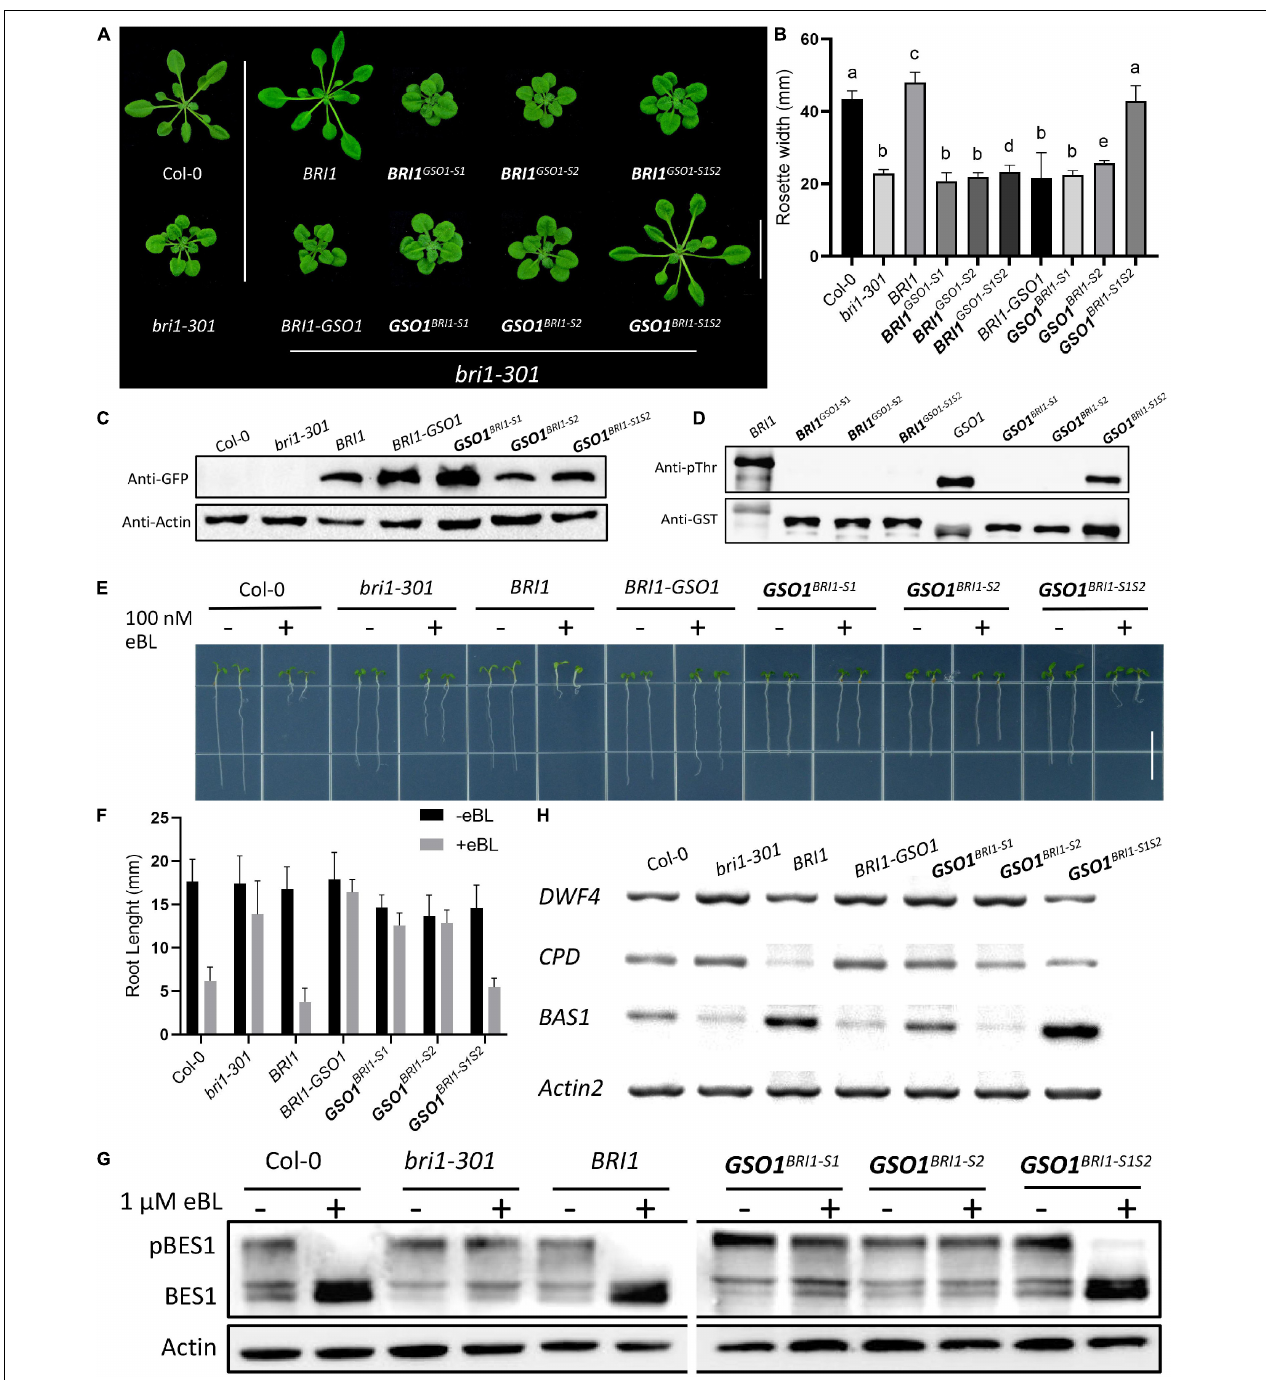
FIGURE 4 | The kinase function of BRI1 defined by two separate domains. (A) The phenotypes of transgenic lines expressing different chimeric receptors of BRI1 and GSO1. Only chimeric receptors with both the S1 and S2 domains of BRI1 ( BRI1 and GSO1 BRI 1 - S1 S 2 ) rescued the mutant phenotypes but not the others ( GSO1 BRI 1 − S 1 , BRI1 GSO 1 − S 1 , BRI1 GSO 1 − S 2 , and GSO1 BRI 1 − S 2 ). Scale bar = 2.0 cm. (B) Measurement of rosette width of transgenic lines ( n = 15), p < 0.0001, one-way ANOVA with a Tukey’s test. (C) The protein expression level of corresponding lines. Actin served as a loading control. (D) Phosphorylation of GST-fused BRI1, GSO1, and their chimeras. The anti-pThr antibody was used to detect the autophosphorylation level. GST-tagged proteins were detected by anti-GST antibody served as a loading control. (E) The root of the 7-day-old seedling grown under light conditions on 1/2MS media supplemented with eBL (24-epibrassinolide). Scale bar = 1.0 cm. (F) Comparison of root length in wild type, bri1-301, and transgenic lines ( n = 13). (G) The dephosphorylation levels of BES1. The total protein was extracted from 14-day-old seedlings, and phosphorylated (pBES1) and dephosphorylated BES1 were detected with BES1 antibodies. Actin served as a loading control. (H) Expression levels of BR biosynthetic genes, DWF4, CPD, and BAS1 in wild type, bri1-301, and transgenic lines. ACT served as a loading control.